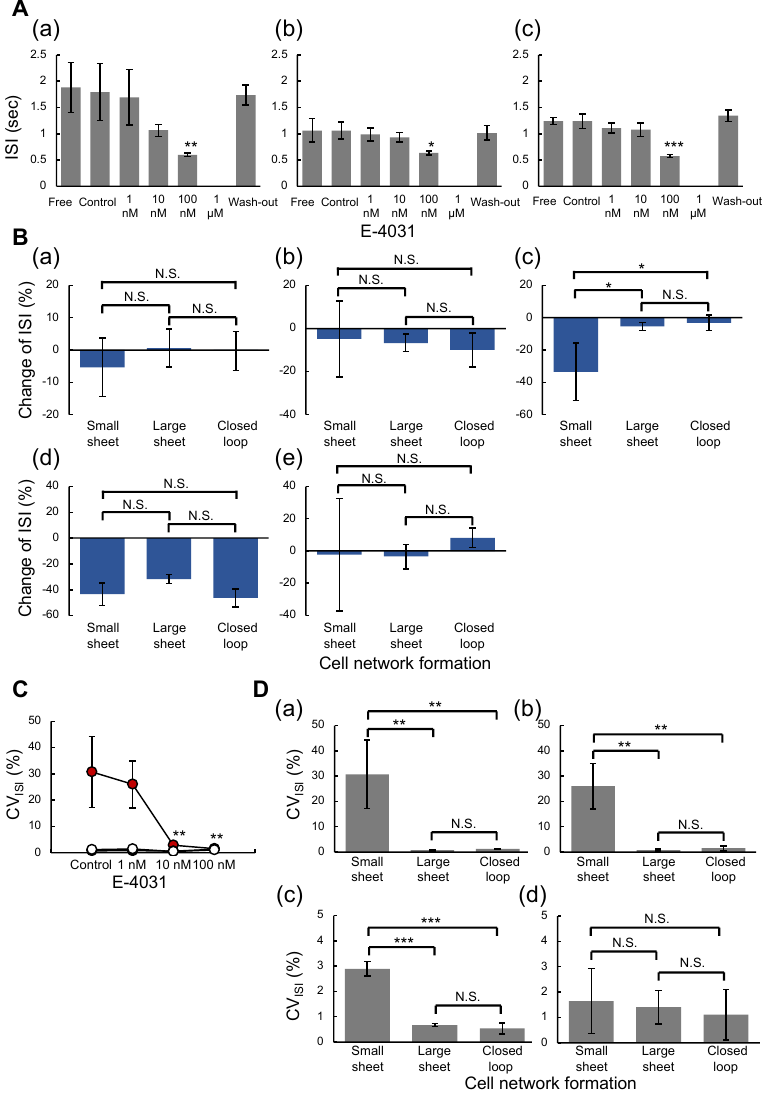
Figure 4. Evaluation of hERG ion channel blocking on beating intervals in three type cardiomy- ocyte network patterns. ( A ): E-4031 concentration dependence of inter-spike intervals (ISIs) in three type cardiomyocyte networks: ( a ) small sheet (n = 3), ( b ) large square sheet (n = 3) and ( c ) square closed-loop-shaped sheet (n = 3). Bars, mean values. Error bars, S.D. Dunnett’s multiple comparison test, * p < 0.05, ** p < 0.01, and *** p < 0.001 vs. Control state. ( B ): Change in ISI in three cardiomyocyte network patterns: ( a ) Free to Control (n = 3 each), ( b ) Control to Low (n = 3 each), ( c ) Low to Medium (n = 3 each), ( d ) Medium to High (n = 3 each) and ( e ) Free to Wash-out (n = 3 each). Bars, mean values. Error bars, S.D. Tukey’s multiple comparison test, * p < 0.05. ( C ): Coefficient of variability (CV) of ISI values against E-4031 concentration. The red-filled circles, black-filled circles, and open circles indicate the mean CV values of the small sheet, large square sheet, and square closed-loop-shaped sheet group, respectively (n = 3 each). Dunnett’s multiple comparison test, ** p < 0.01 vs. Control state. ( D ): CV of ISI in three cardiomyocyte network patterns: ( a ) Control state (n = 3 each), ( b ) Low state (n = 3 each), ( c ) Medium state (n = 3 each) and ( d ) High state (n = 3 each). Bars, mean values. Error bars, S.D. Tukey’s multiple comparison test, ** p < 0.01 and *** p <